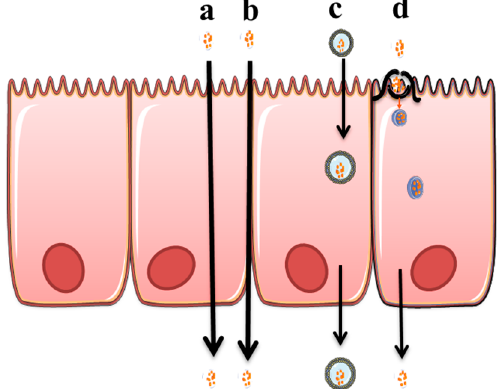
Figure 1. Mechanisms of absorption includes; (a) Transcellular diffusion, (b) Para cellular transport, (c) Vesicle mediated transport, and (d) Carrier mediated transport .